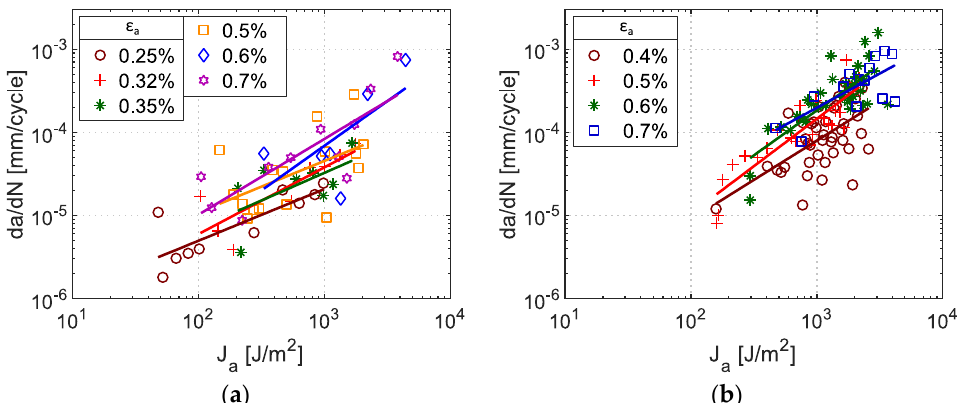
Figure 15. Short crack growth rate vs. J-integral amplitude under cycling with total strain amplitudes ε a : ( a ) Sanicro 25, ε a = 0.25%–0.7%, ( b ) 304L, ε a = 0.4%–0.7%.